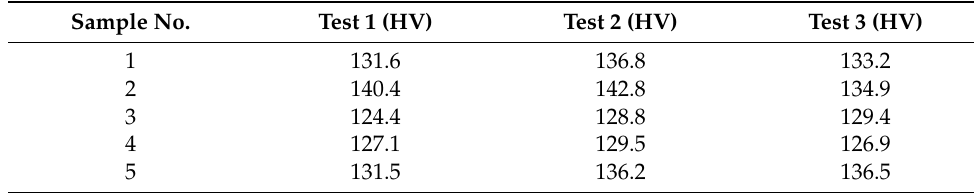
Table 4. The hardness of the forging